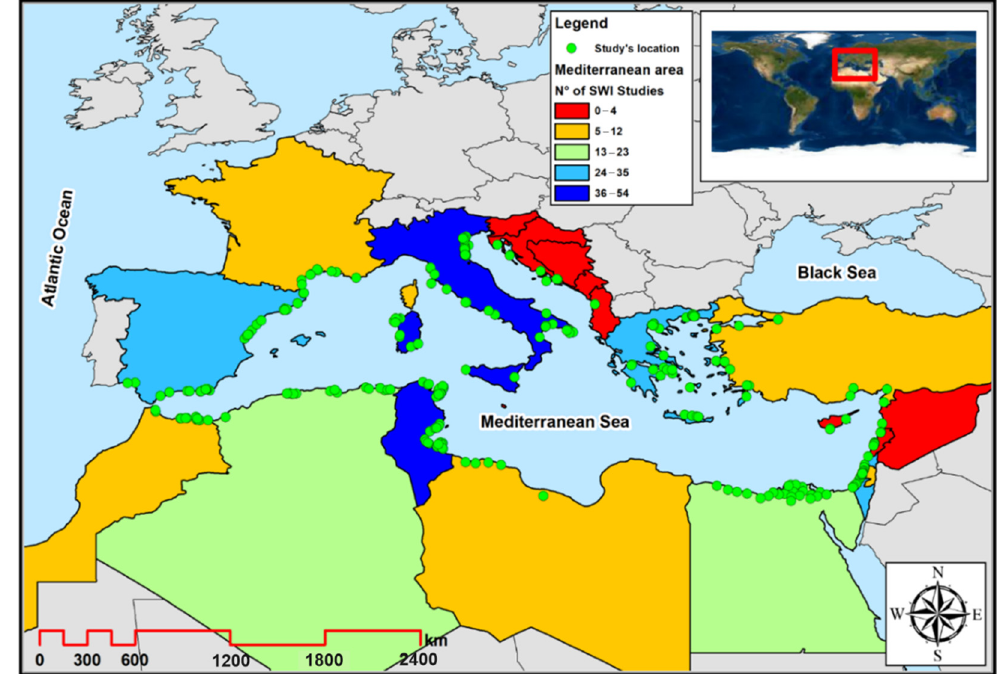
Figure 1. Distribution of the studies focusing on groundwater (GW) salinization along the Mediterranean